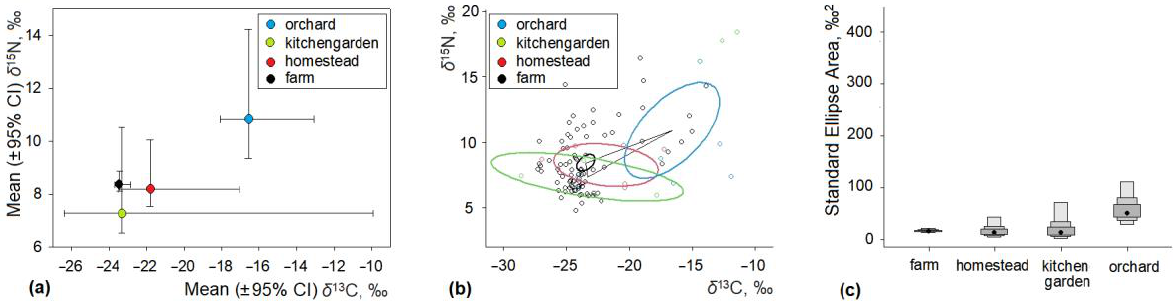
Figure 2. Position of M. musculus in isotopic space according to hair sample stable isotope ratios in the gradient of anthropogenic disturbance of habitats, from orchards to farms ( a ), ellipses, representing isotopic niche width areas of the mice from different habitats ( b ), and SEA density plots, representing the credibility intervals of the Bayesian SEA with shaded boxes encompassing the 50th, 75th and 95th (shown from dark to light) credibility intervals for different habitats ( c ).